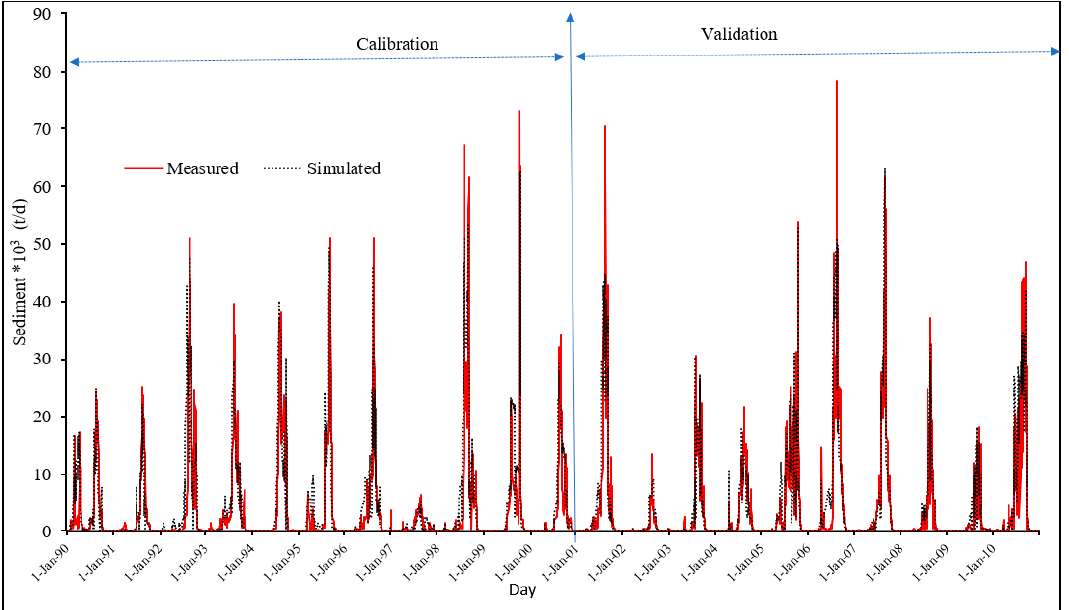
Figure 6. Sediment yield calibration and validation at Abura gauging station.